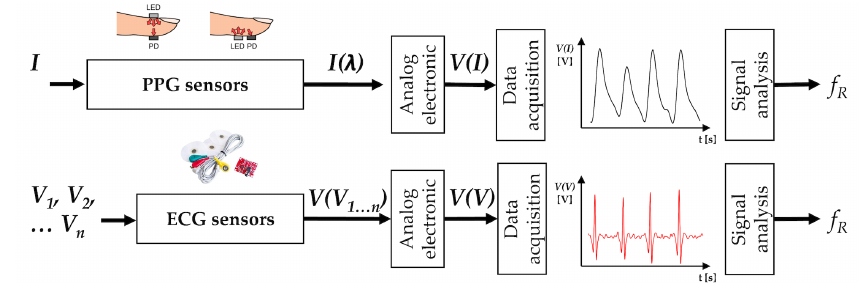
Figure 10. Sensors for recording breathing modulatory effect on cardiac activity: the main elements composing the measuring chain (sensor, analog electronics, data acquisition, post-processing or signal analysis stage) to estimate f R . Analog electronic stages vary between different sensors since the output quantities are different. I ( λ ) , V ( V 1,2,3,..., n ) are light intensity and biopotential signals (number 1,2,3, ..., n depends on the number of ECG channels), respectively. V ( . ) is the voltage output. The